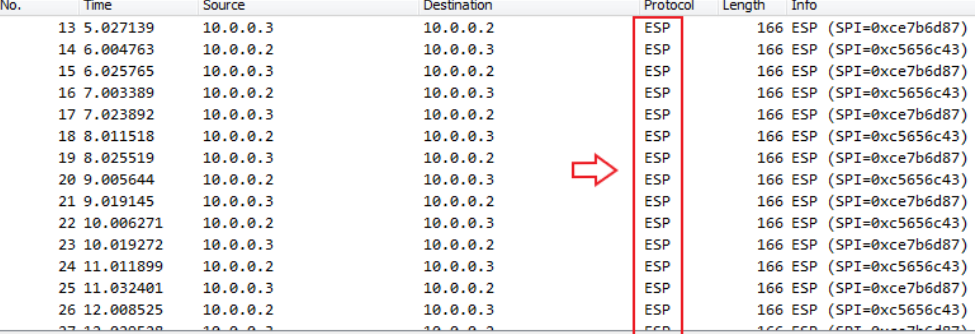
Figure 9. Encrypted payloads.